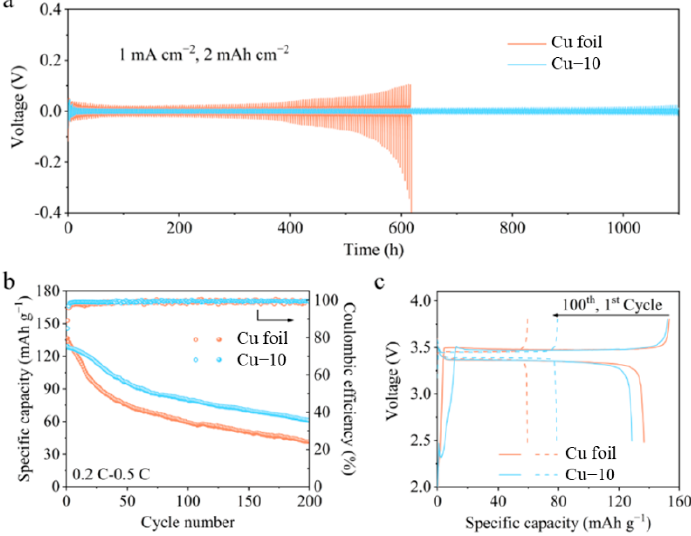
Figure 6. ( a ) Voltage profiles of the symmetric cells using the commercial Cu foil and Cu − 10. ( b ) Cycling performance and ( c ) galvanostatic charge-discharge profiles of the anode-free full cells using the commercial Cu foil and Cu − 10.